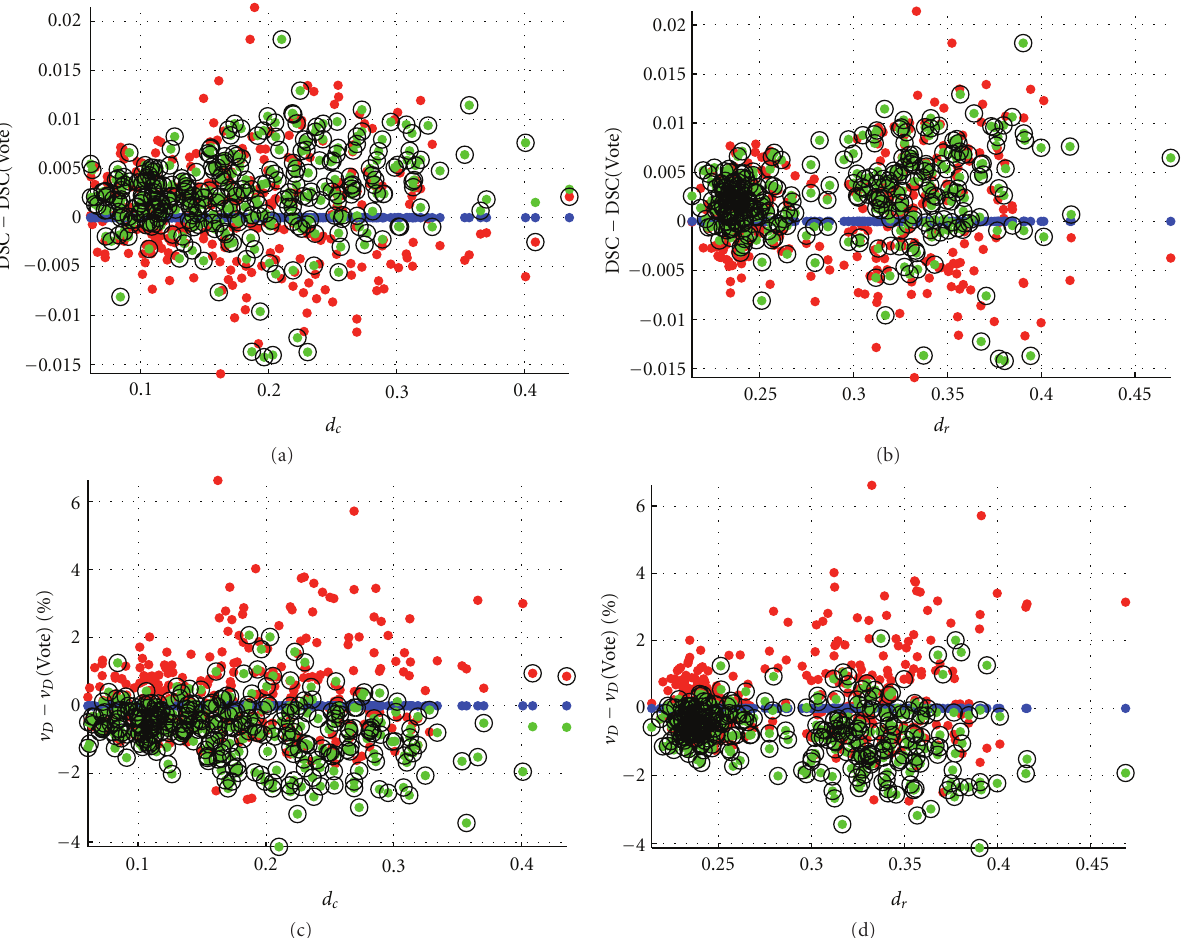
Figure 9: Scatter plots of (a, b) DSC and (c, d) v D , centered on Vote values, as functions of (a, c) d c and (b, d) d r for the 312 label fusion tests of the real data set using SVS-2D&3D. The results were nearly identical for SVS-2D and SVS-3D. The centered DSC ( v D ) corresponds to DSC ( v D ) minus DSC ( v D ) evaluated for Vote. DSC and v D are represented as dots for STAPLE (red), Vote (blue), and SBA (green), and as black circles for